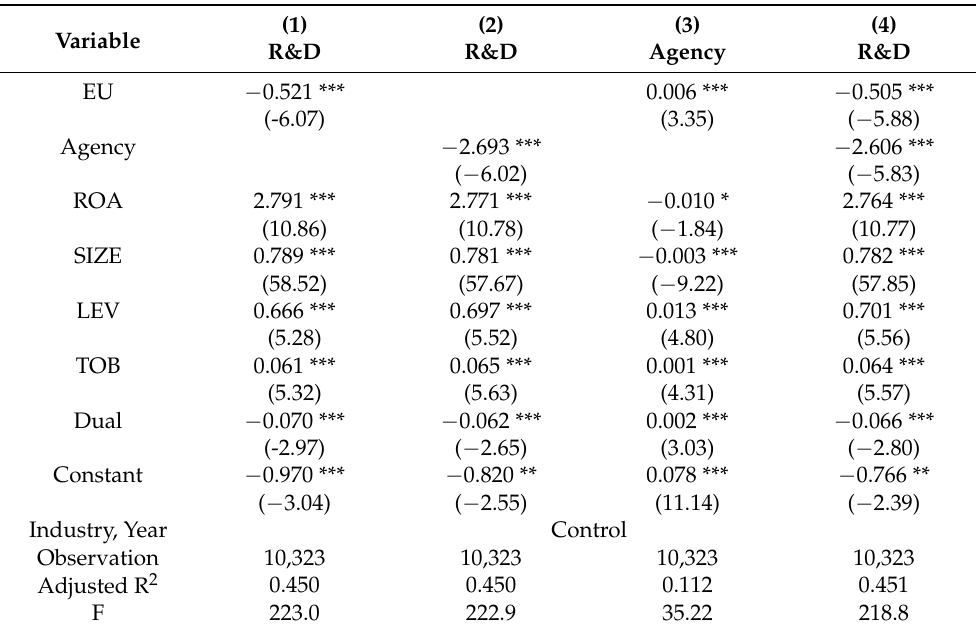
Table 4. Regression analysis of environmental uncertainty, the second type of agency problem and innovation